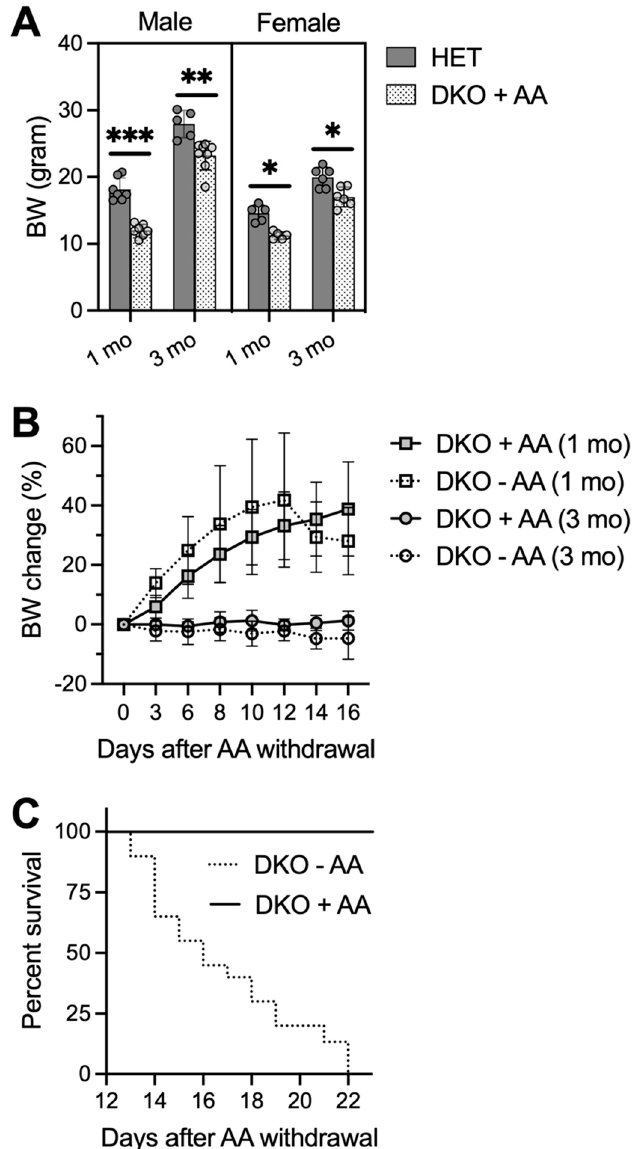
Figure 4. AA-rescued DKO mice die 2-3 weeks after AA removal. Small bottles of freshly-prepared water containing AA (1 g/L) were provided for pre-weanling pups in nursing cages starting at PND16. AA-rescued DKO mice were weaned at PND21-23 and kept on AA-supplemented drinking water (1 g/L) until at the age of 1 or 3 months when AA was removed from the drinking water or until conclusion of the study. ( A ), body weights (BW) of male and female HET and AA-rescued DKO mice at ages of 1 and 3 months ( N = 6–8/group). ( B ), BW change of AA-rescued DKO mice after AA removal ( − AA) or maintained on AA (+AA) (N = 5–6/group). ( C ), survival rate of AA-rescued DKO mice after AA removal ( − AA; N = 19) or maintained on AA (+AA; N = 15). Data are expressed as means ± S.D. * p < 0.05, ** p < 0.01, *** p < 0.001, when compared to age- and gender-matched HET mice by Student’s unpaired t -test.